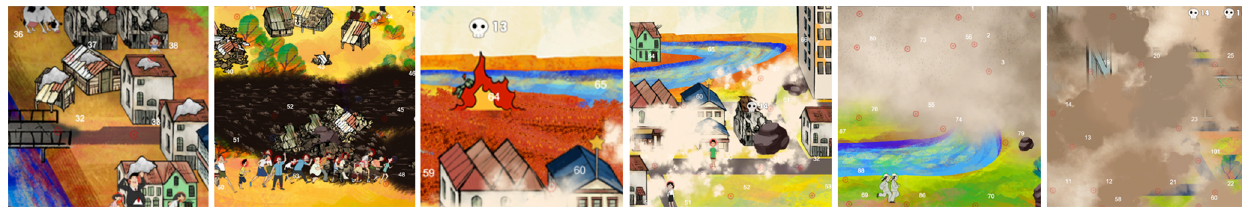
Figure 1. Details of visual characterizations of volcanic hazards in the game (left to right): ashfall, mudflow, lava, gas and rockfall, partial burning clouds, and total burning